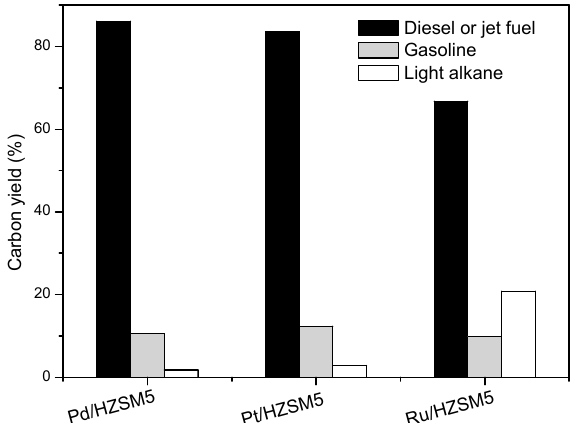
Figure 7. Carbon yields of C 9 –C 15 diesel alkanes (black columns), C 5 –C 8 gasoline alkanes (grey columns), and C 1 –C 4 alkanes (white columns) over M/H-ZSM-5 (M = Pt, Pd or Ru) catalysts. Experimental conditions: 1.8 g catalyst, 6.0 MPa H 2 , 573 K, 0.04 mL min − 1 liquid feedstock flow rate, and 120 mL min − 1 H 2 flow rate.